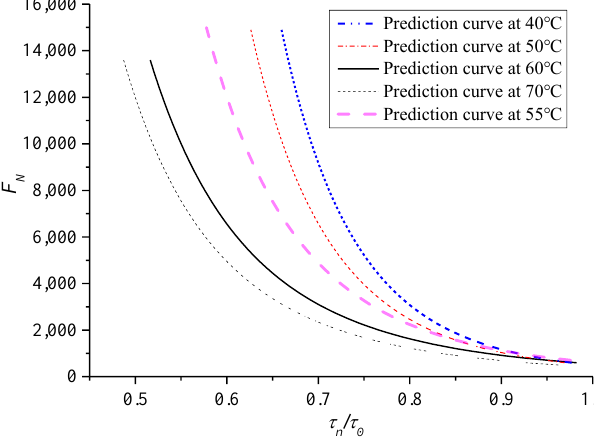
Figure 19. Predicted curves of F N at different temperatures.